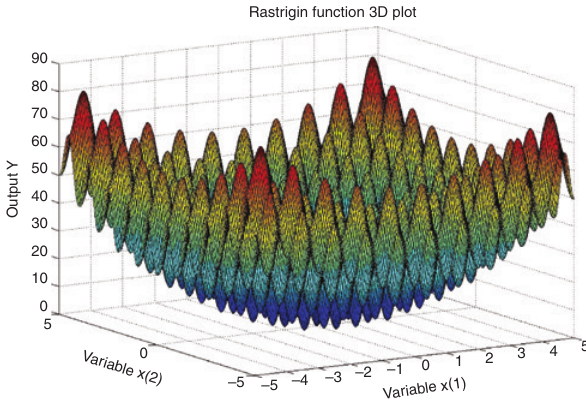
Figure 1: Two-Dimensional Rastrigin